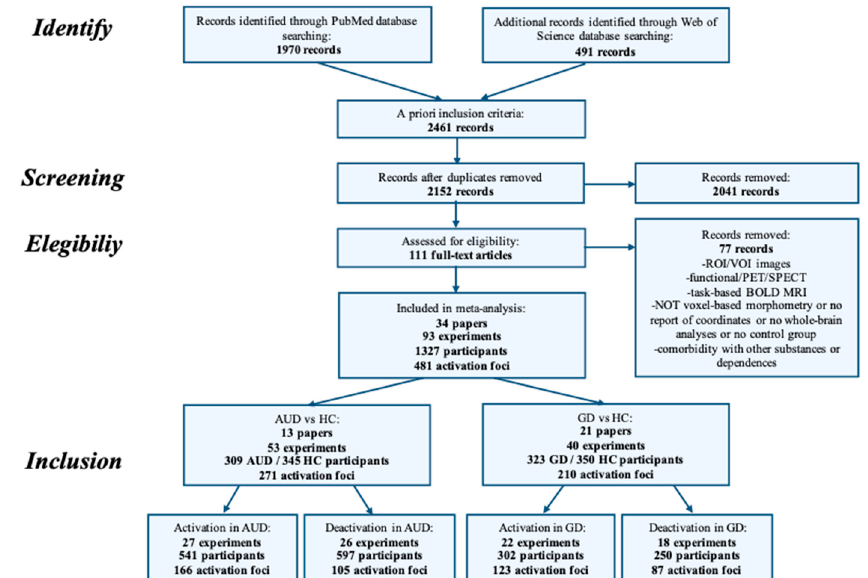
Figure 1. Flowchart illustrating the selection procedures for and details about the materials included in the meta-analysis. ROI = Region of Interest; VOI = Volume of Interest; PET = Positron Emission Tomography; SPECT = Single-Photon Emission Computed Tomography; BOLD = Blood Oxygenation Level Dependent; MRI = Magnetic Resonance Imaging; GD = Gambling Disorder; AUD = Alcohol Use Disorder; HC = Healthy Control.